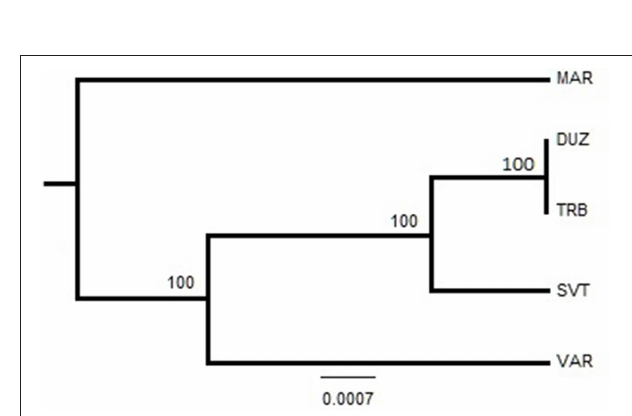
TABLE 5 | Pairwise genetic distance based on sequence analysis of the COIII region between populations of S. maximus (below diagonal), and genetic diversity within samples (transversal diagonal as given in bold).